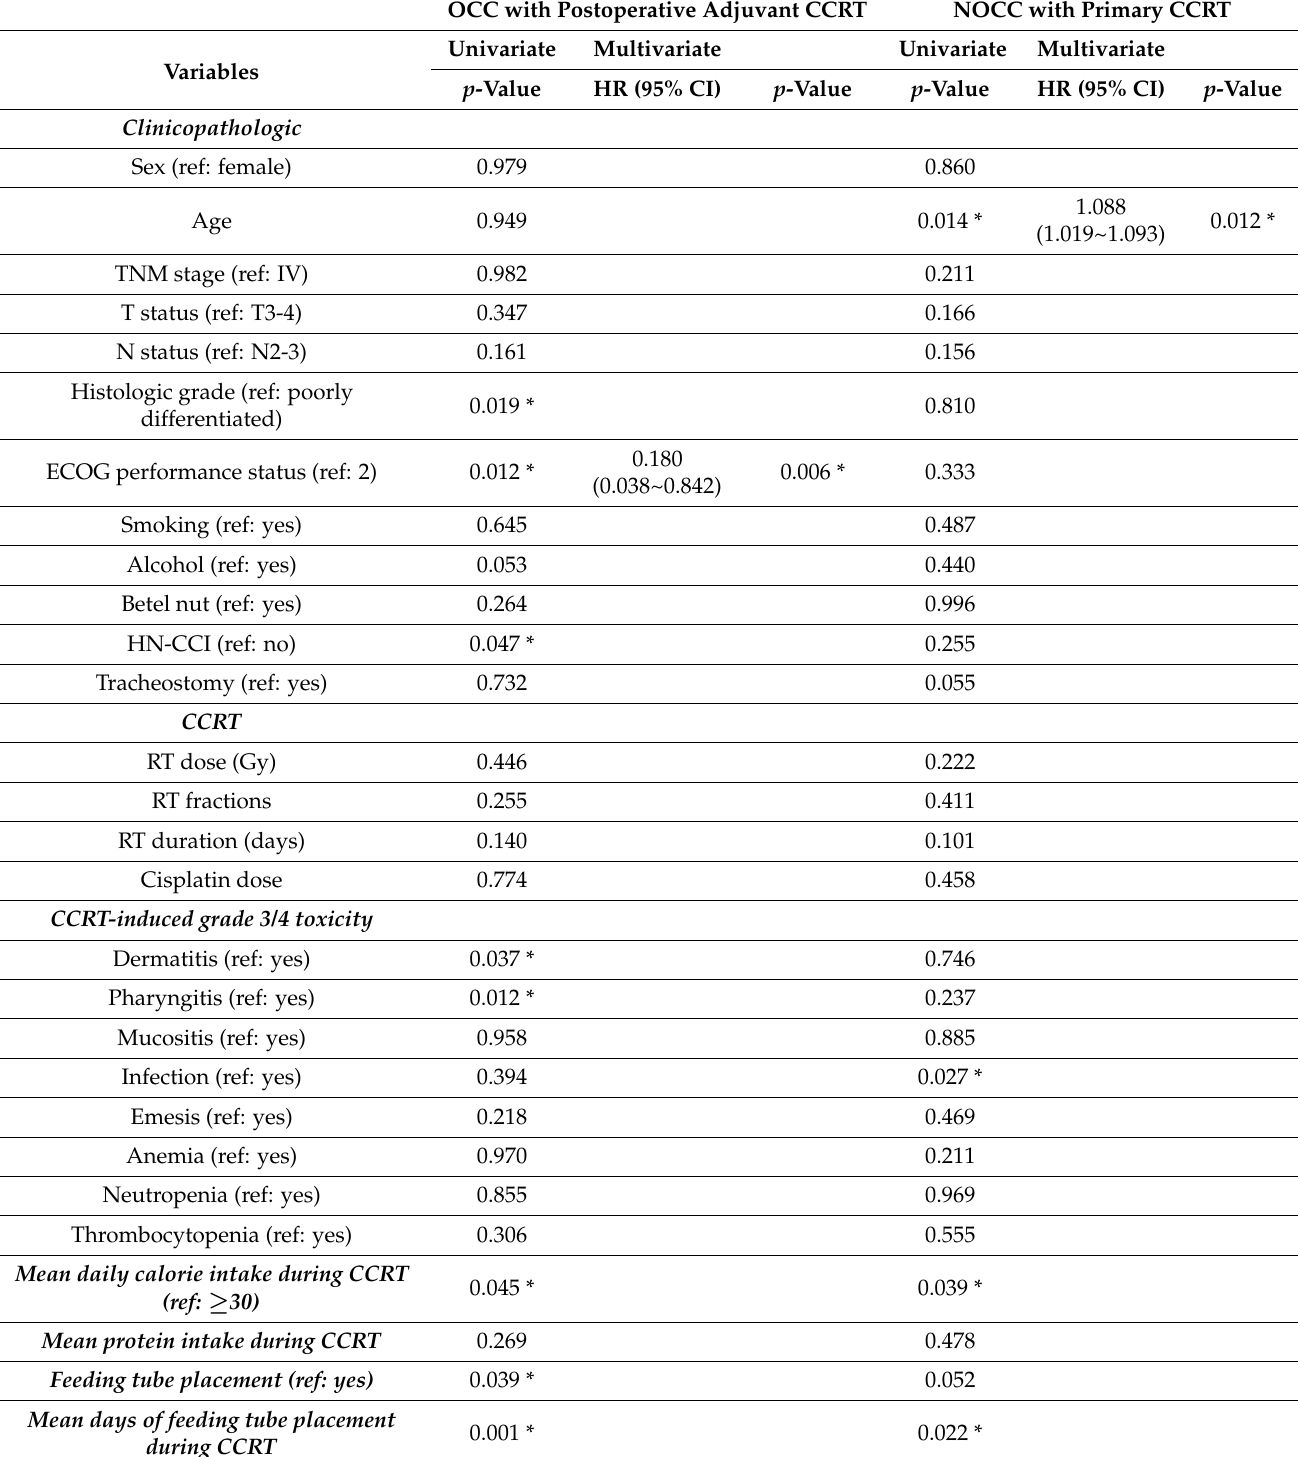
Table 4. Univariate and multivariate Cox regression analyses of factors associated with 2-year mortality rates of 69 OCC patients treated with postoperative adjuvant CCRT and 54 NOCC patients treated with primary